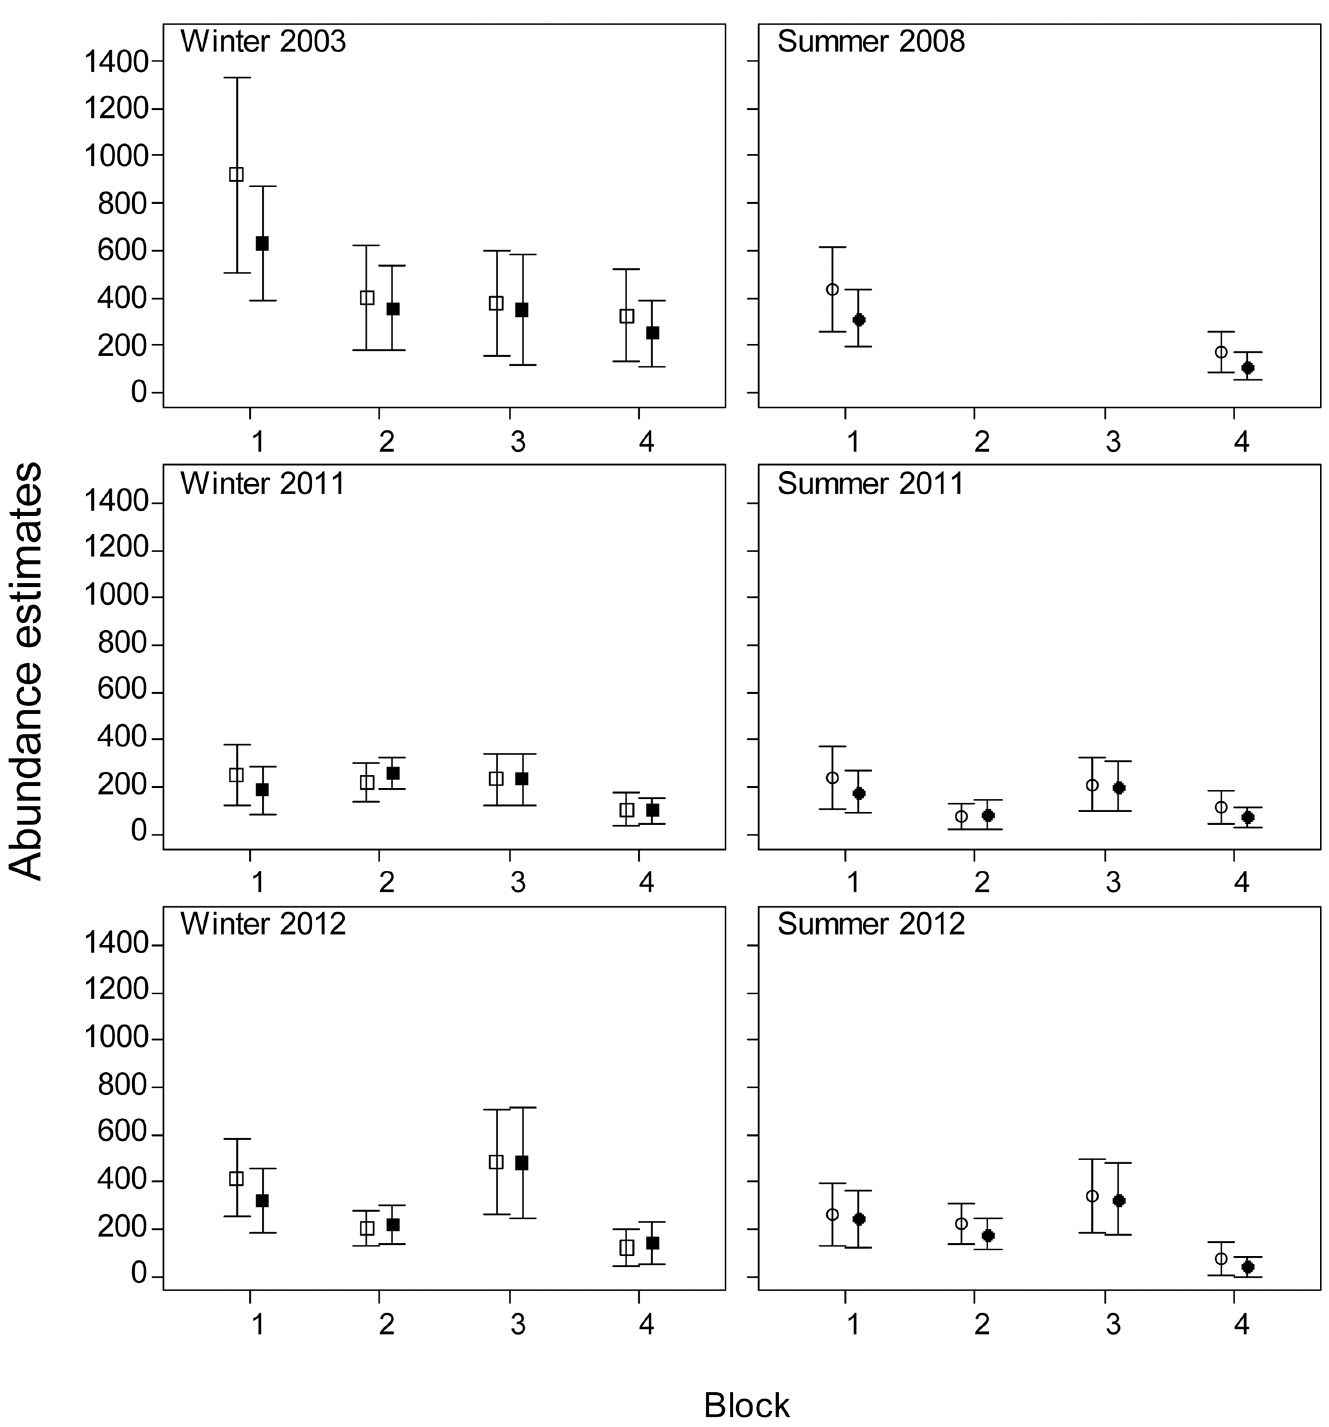
Fig 5. Population abundance estimates ± SE (vertical lines) in New Caledonia obtained using the availability detection probabilities from Pollock et al. [18] (open squares) and this study (closed squares).